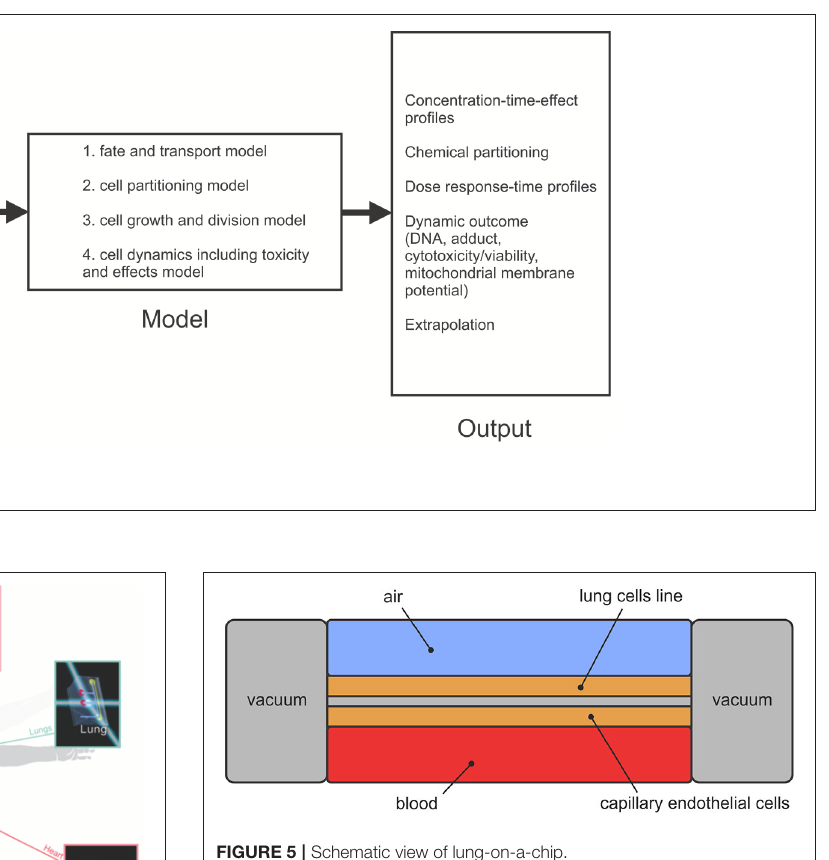
FIGURE 5 | Schematic view of